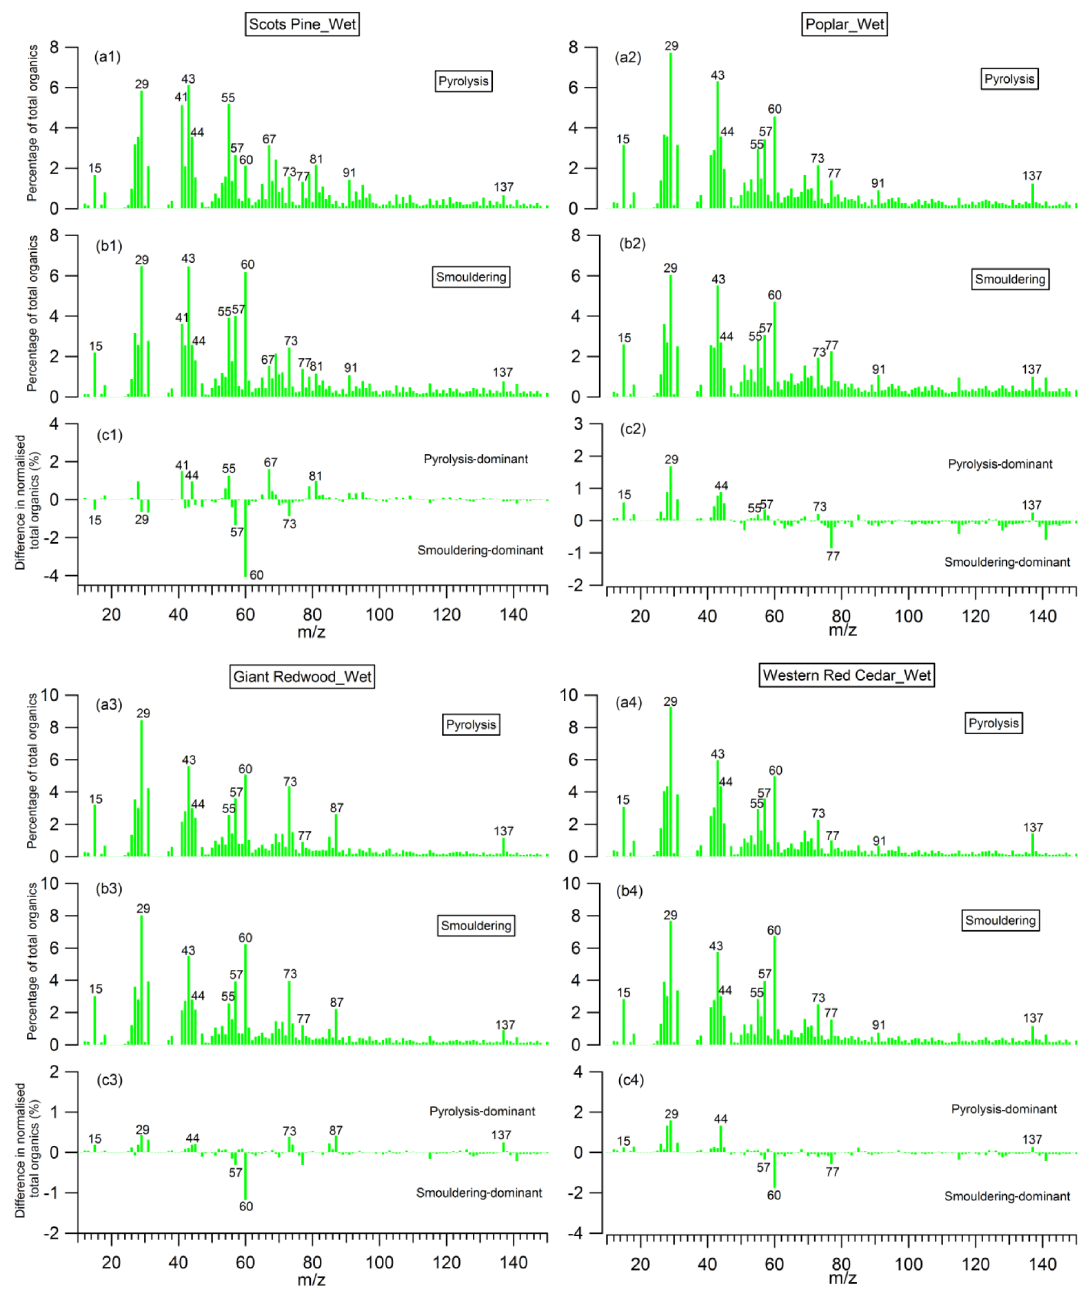
Figure 11. Mass spectra of organic aerosols (OA) presented as a percentage of total OA produced during (a) the pyrolysis phase and (b) the smouldering phase; and (c) the difference between them, for the wet wood